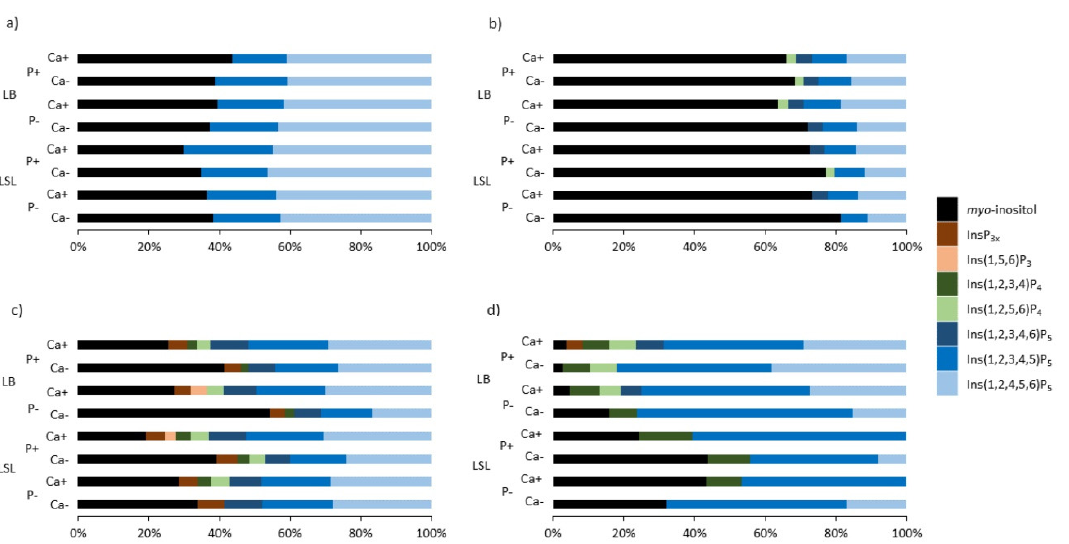
Figure 2. Relative proportions of the concentrations of InsP 3-5 isomers and myo -inositol in the digesta of the crop ( a ), jejunum ( b ), terminal ileum ( c ), and ceca ( d ) of two laying hen strains (LB and LSL) aged 31 weeks. The sum of the concentrations of InsP 3-5 isomers and myo -inositol on a molar basis is defined as 100%. The InsP pattern in the crop is mainly derived from the InsP present in the feedstuff. The pattern became more diverse in the jejunum and even more in the ileum before it got less diverse in the ceca.